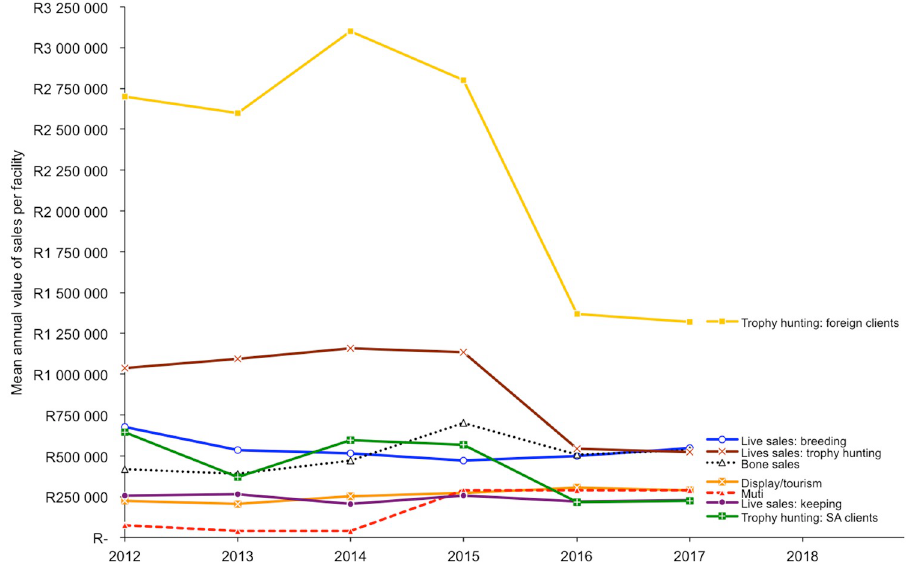
Fig 3. Estimated mean annual value of sales (in ZAR) per facility for income-generating activities from lions. Graph showing values in USD in Figure E in S1 Figs, where mean annual ZAR:USD exchange rates: 2012 (1: 0.122); 2013 (1: 0.104); 2014 (1: 0.092); 2015 (1: 0.078); 2016 (1: 0.068); 2017 (1: 0.075). Results correspond to Questions 15 and